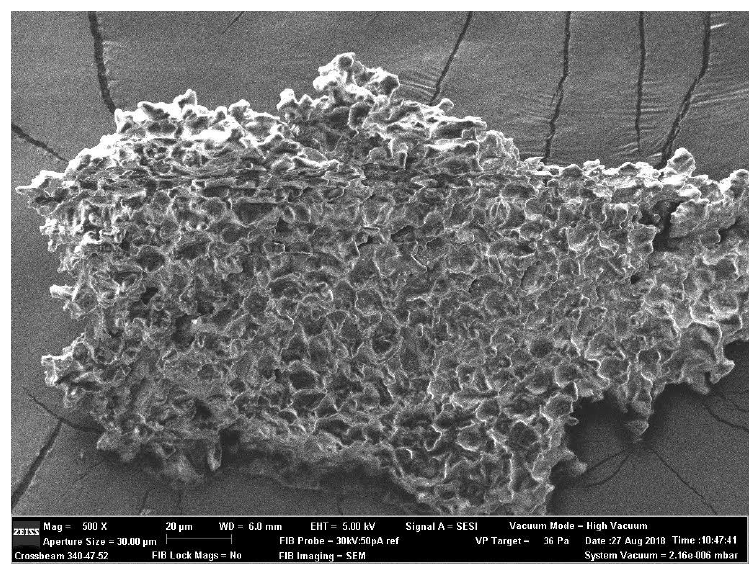
Figure 2. FESEM microphotograph of deshelled Carica papaya seeds at 500× magnification.